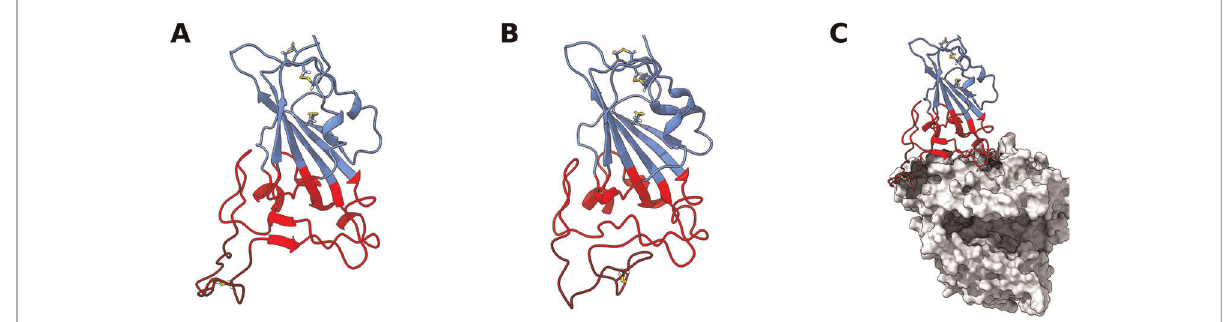
FIGURE 1 SARS-CoV-2 receptor binding domain (RBD) structure. Structure of wt RBD in the open ( A ) and closed ( B ) conformations. Snapshots obtained from the AA MD simulations. Disul fi de bonds are represented in yellow sticks. Structure of wt RBD bound to ACE2 is also shown ( C ). The RBM region is colored red and the ridge in dark red, with the rest of the protein being colored in blue. ACE2 is in